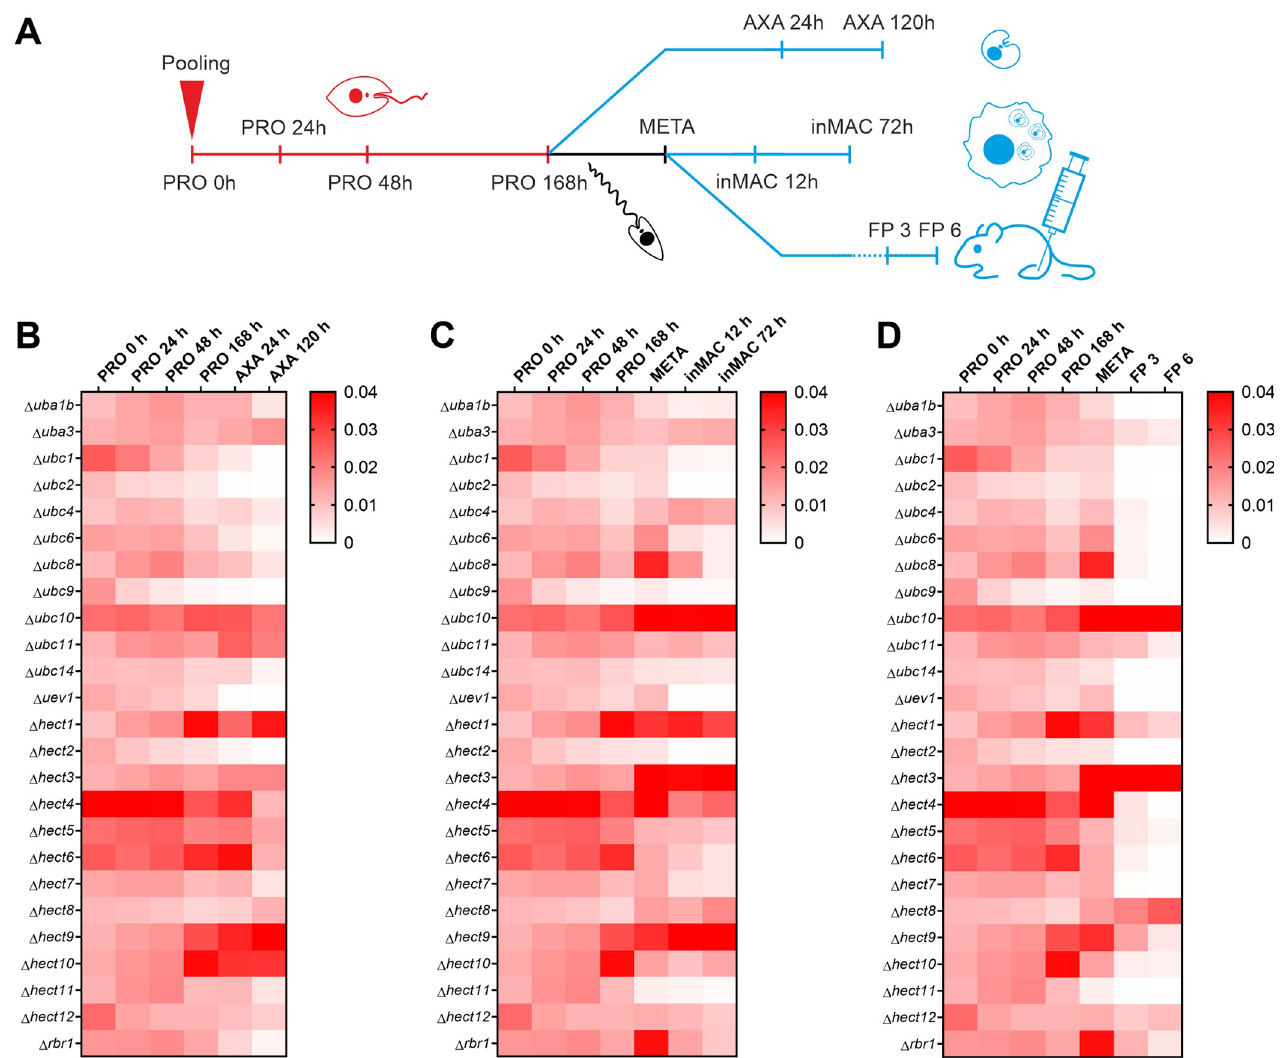
Fig 1. Life cycle phenotyping of ubiquitination gene null mutants. Fifty-eight null mutant lines were pooled (n = 6) as procyclic promastigotes and grown to stationary phase. Cells were then induced to differentiate into axenic amastigotes in vitro or metacyclic promastigotes purified and used to infect macrophages or mice. A Experimental workflow showing the time points at which DNA was extracted for barcode amplification and next generation sequencing. The heat maps for promastigote to B axenic amastigote, C macrophage infection or D mouse infection experiments show the average proportional representation of each null mutant at each experimental time point, calculated by dividing the number of reads for null mutant-specific barcodes by the total number of reads for expected barcodes. Samples included represent promastigote time-point zero (PRO 0 h), early-log phase (PRO 24 h), mid-log phase (PRO 48 h), late-log phase (PRO 72 h), stationary phase (PRO 168 h), early axenic amastigote differentiation (AXA 24 h), post-axenic amastigote differentiation (AXA 120 h), purified metacyclic promastigotes (META), early macrophage infection (inMAC 12 h), late macrophage infection (inMAC 72 h), 3 week footpad mouse infection (FP 3) and 6 week footpad mouse infection (FP